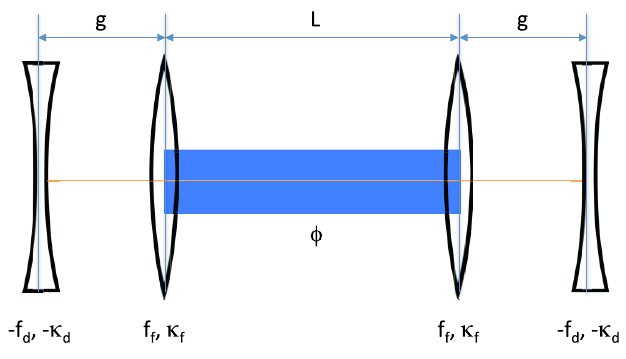
FIG. 4. A periodic theoretical minimum emittance cell with dipole, quadrupole, and sextupole magnets. ϕ and L are the bending angle and length of the dipole, f the focus lengths of f;d the quadrupoles, κ the strengths of the sextupoles. f;d